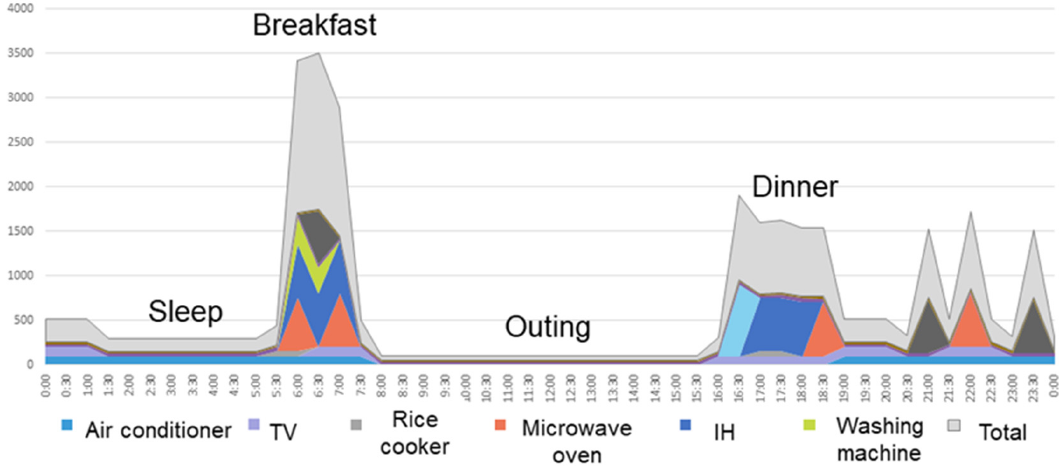
Figure 2. An example of estimated behavior of residents by NILM technology. This technology provides insight into various activities at home via estimated usage time of major home appliances.